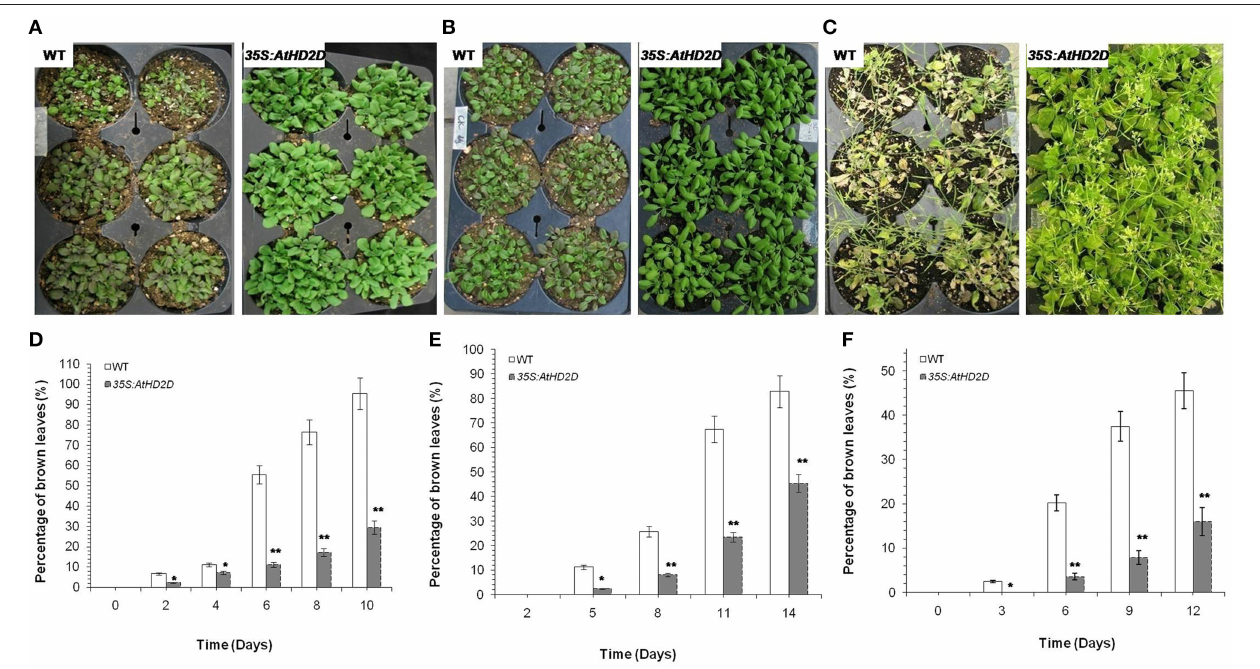
FIGURE 6 | Full view of wild type (WT) and 35S:AtHD2D transgenic plants under abiotic stresses. The error bars represent the SD . The data are presented as the mean ± standard deviation of the mean ( SD ) and were tested for significant difference using Student’s t -test ( * p < 0.05 , ** p < 0.01 ). (A) WT and 35S:AtHD2D transgenic plants under cold stress for 8 days. (B) WT and 35S:AtHD2D transgenic plants under drought stress conditions for 9 days. (C) WT and 35S:AtHD2D transgenic plants under salt stress conditions for 18 days. (D) Browning levels in leaves of WT and 35S:AtHD2D transgenic plants under cold stress. (E) Browning levels in leaves of WT and 35S:AtHD2D transgenic seedlings under drought stress. (F) Browning levels in leaves ofWT and 35S:AtHD2D transgenic seedlings under salt